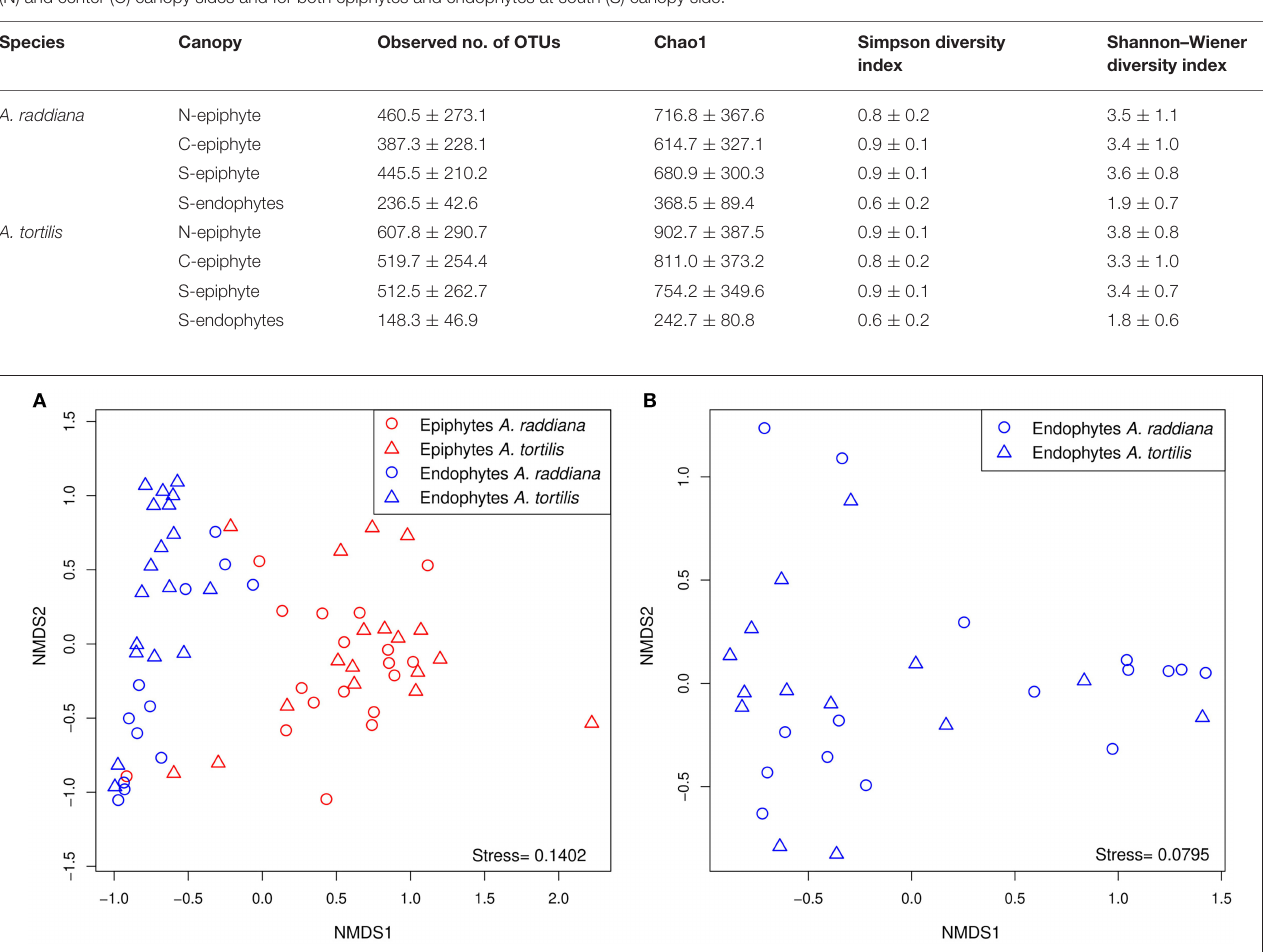
FIGURE 2 | NMDS illustrating the phyllosphere bacterial community; separate clusters of bacterial communities are evident for (A) the epiphytic (red) and the endophytic (blue) bacterial communities from leaves sampled from south side canopy areas; and (B) unique clusters of endophytic bacterial communities observed in A. raddiana (blue) and A. tortilis